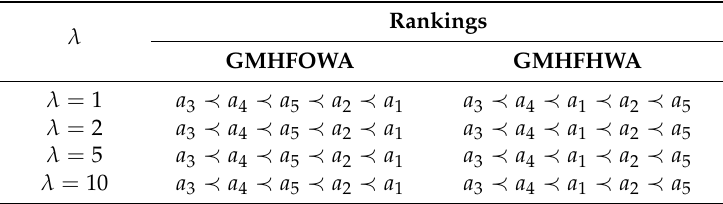
Table 2. Rankings obtained using the GMHFOWA operator and the GMHFHWA